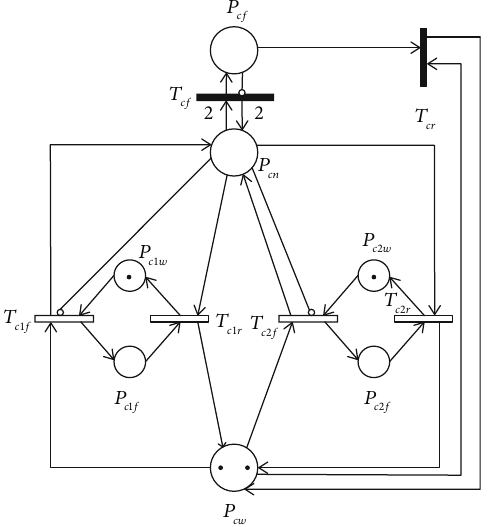
Figure 7: The GSPN model of ARINC664 network. Table 3: Places in GSPN model for ARINC664 network. Place